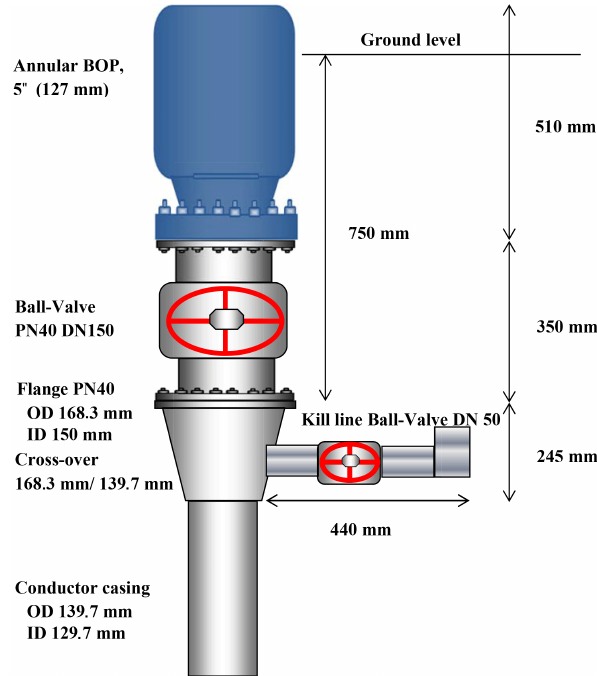
Figure 6. Sketch of the COSC-1 wellhead. A 5 (cid:48)(cid:48) annular blow out preventer (BOP) was attached on top of the main valve, a DN150 ball valve. A DN50 ball valve was used for the kill line.